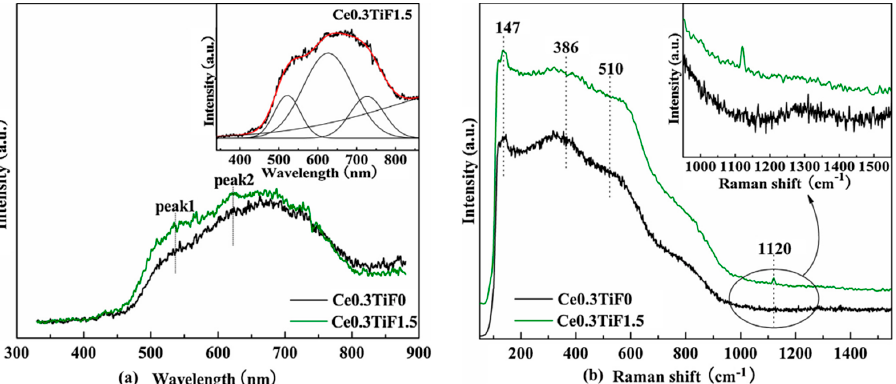
Figure 24. ( a ) PL spectra of Ce 0.3 TiF 0 and Ce 0.3 TiF 1.5 samples, ( b ) Raman spectra of Ce 0.3 TiF 0 and Ce 0.3 TiF 1.5 samples [94].